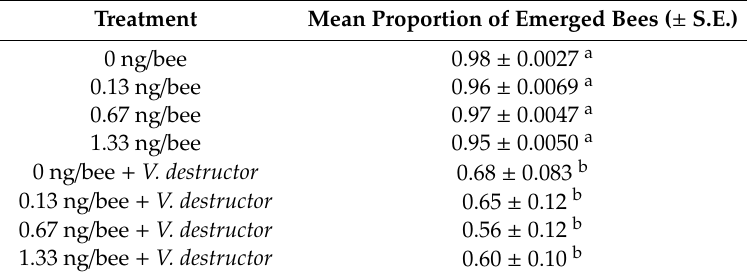
Table 1. Mean proportion of emerged bees ( ± S.E.) exposed to sublethal doses of clothianidin (ng / bee) and / or V. destructor .